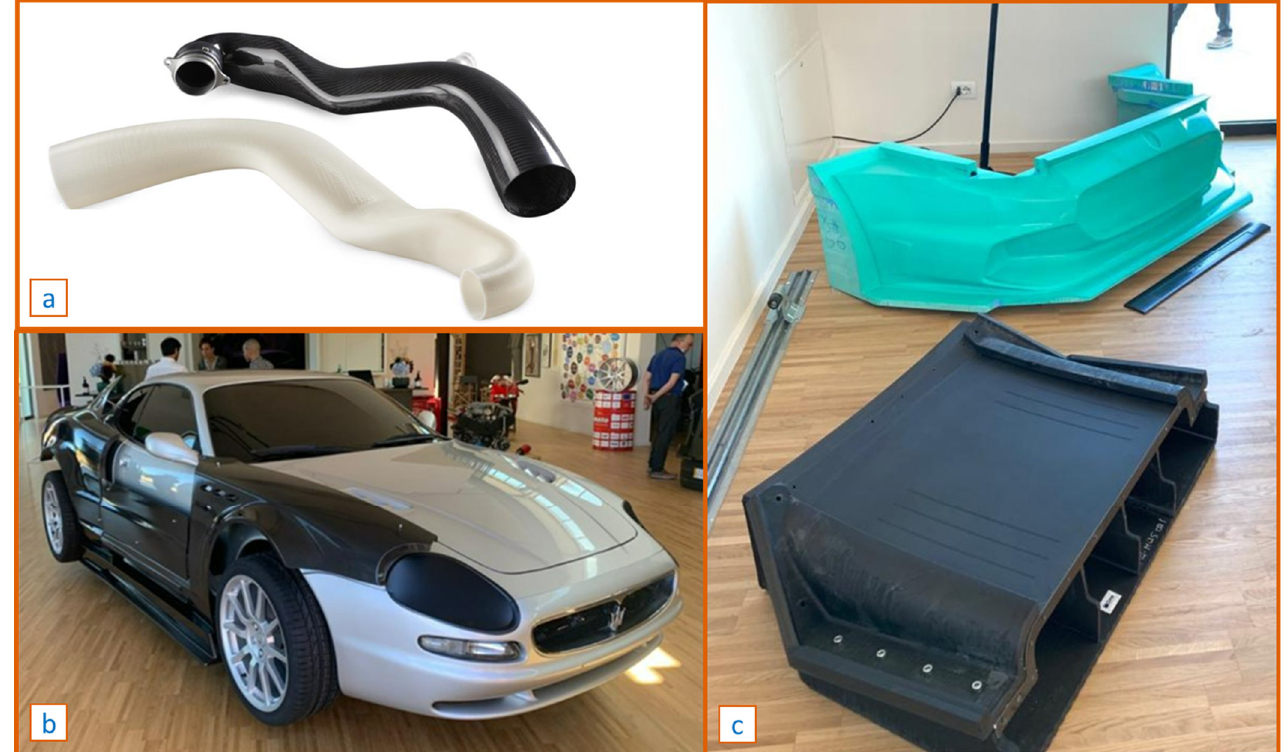
Figure 8. Composite spare-part reconstruction based on indirect AM processes: ( a ) the FDM sacrificial core and the carbon fibre inlet ducts (photo credits: Stratasys/Champion Motorsport; the Maserati MV 3200 GTC ( b ) body components and ( c ) related tooling (photo credits: Bercella Srl).